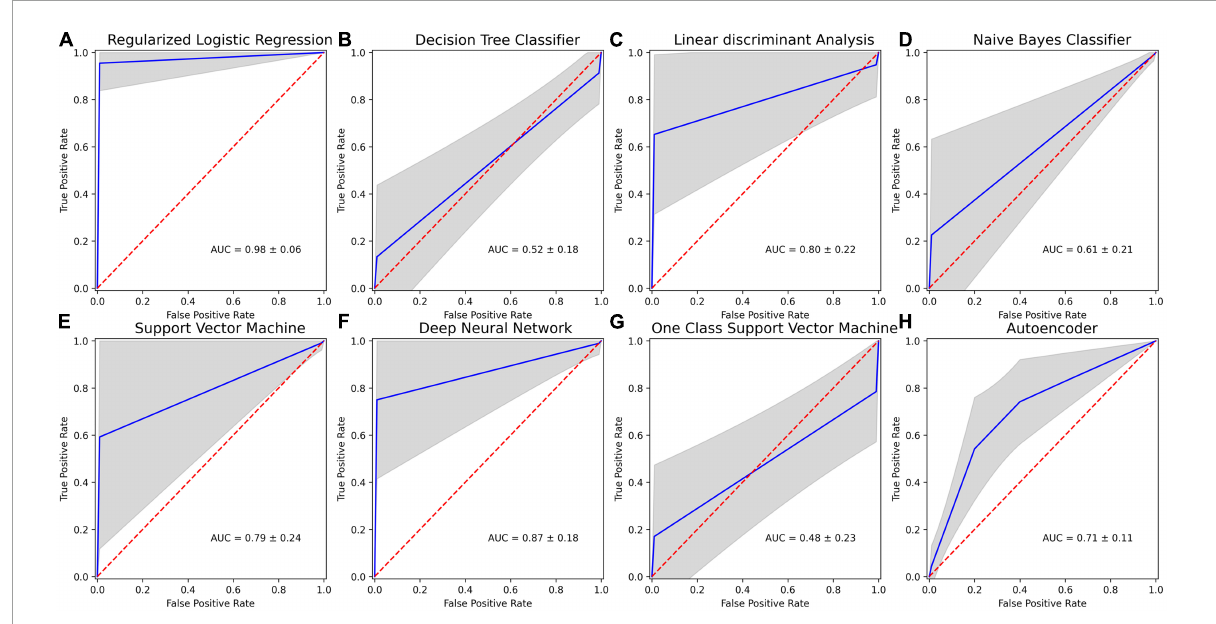
FIGURE4 Receiver operating characteristics (ROC) curves for machine learning (ML) methods applied in post-operative STN-DBS motor outcome prediction using 20 selected features: (A) regularized binary logistic regression (LR); (B) decision tree classifier (DT); (C) linear discriminant analysis (LDA); (D) naive Bayes classifier (NB); (E) kernel support vector machine (SVM); (F) deep feed-forward neural network (DNN); (G) one-class support vector machine (OC-SVM); (H) feed-forward neural network-based autoencoder for anomaly detection (DNN-A). Mean ROC is shown in blue, and one standard deviation is represented by the gray area. Dotted red line indicates chance performance, and curves that deviate more to the top left represent better